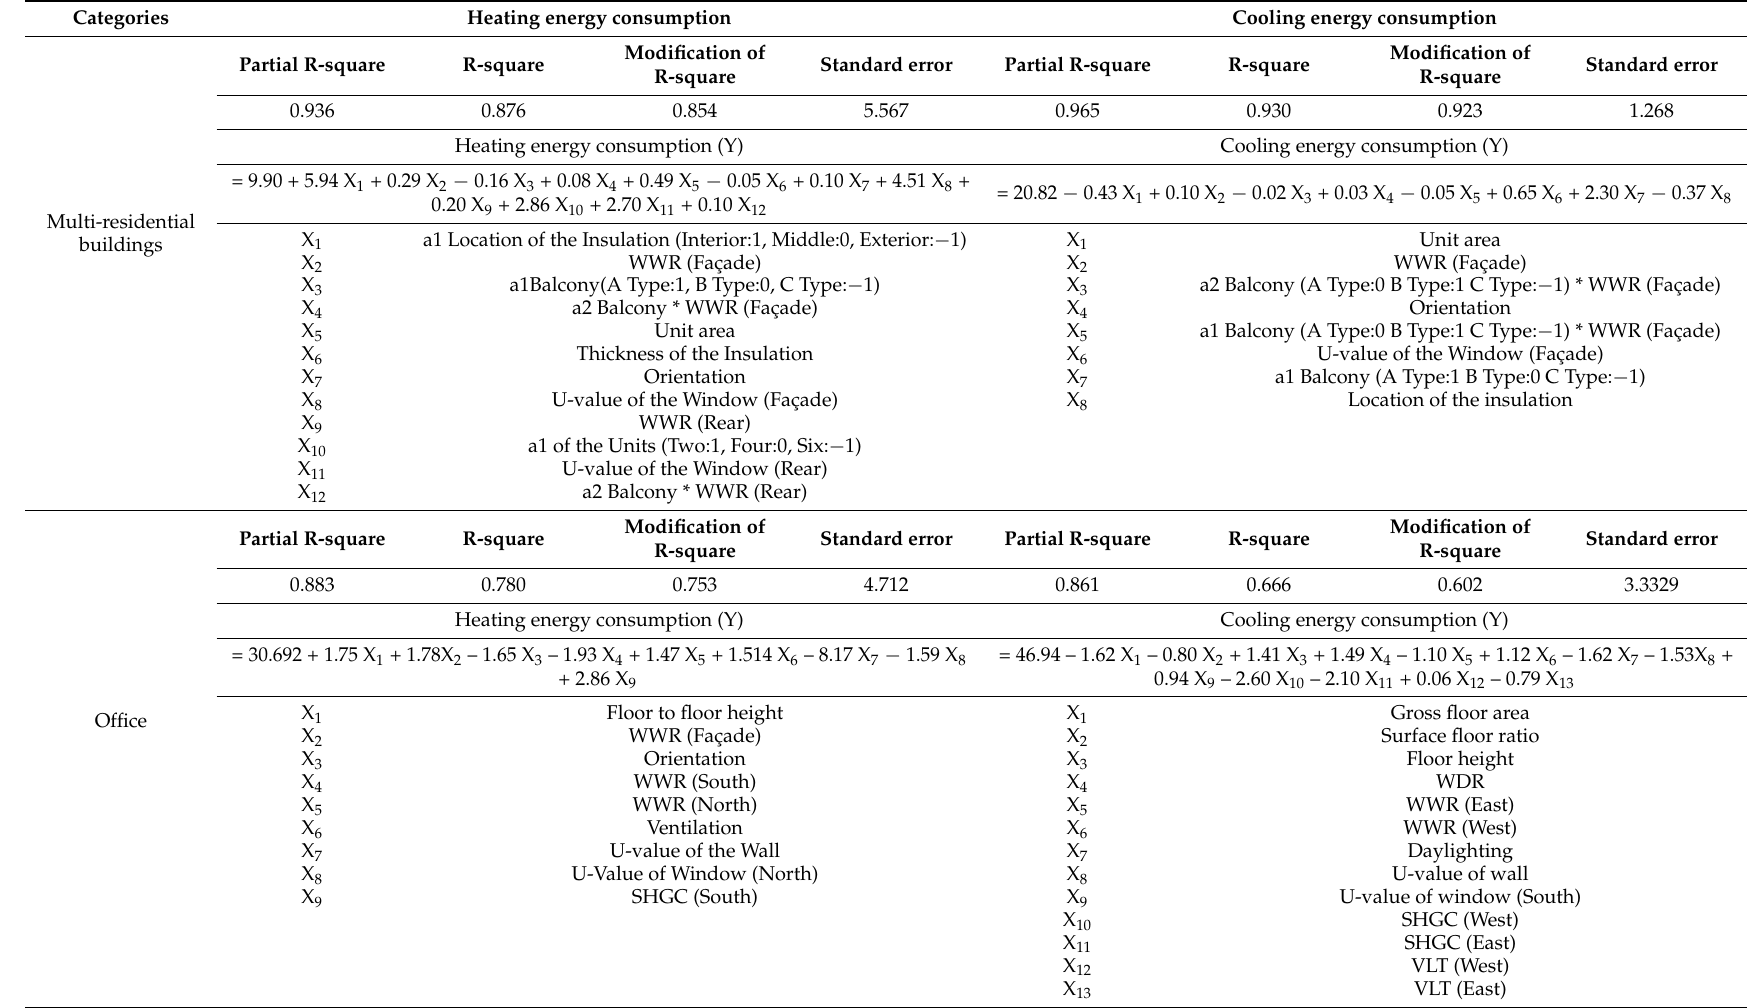
Table 3. Multi-regression analysis